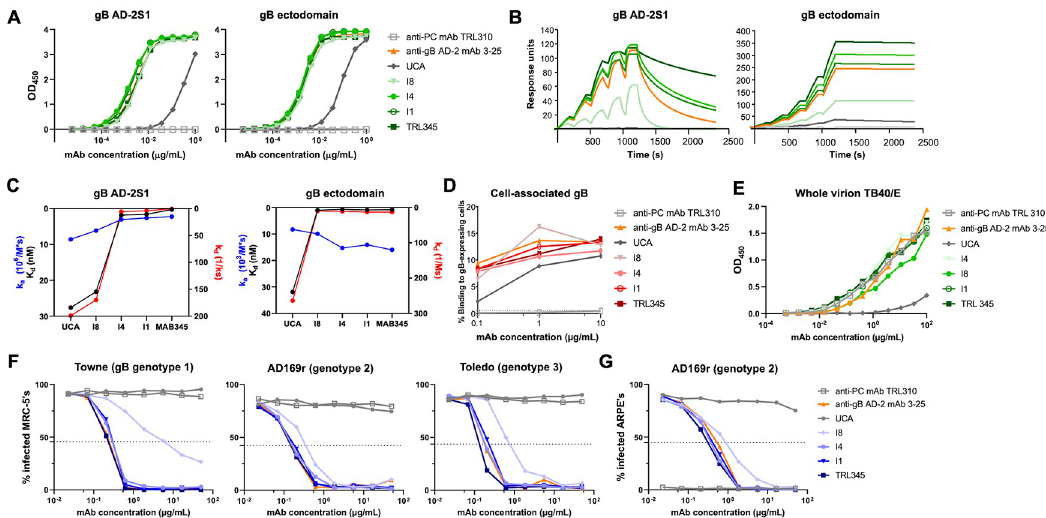
Fig 2. The TRL345 UCA acquired high binding to gB AD-2S1 and broad CMV neutralization function early in lineage development. We produced the 17 clonally related mAbs of the TRL345 lineage and quantified antigen binding and neutralization functions. Shown here are the responses of the lineage ancestors of TRL345: (A). Binding magnitude to gB AD-2S1 peptide and gB ectodomain by ELISA. (B). Binding to and avidity for gB AD-2S1 peptide and gB ectodomain by SPR. (C). Binding coefficients for gB AD-2S1 peptide and gB ectodomain by SPR. K d (nM) was calculated as k d /k a . (D). Binding to cell-associated gB. Binding of mAbs was determined by coincubating mAbs in a serial dilution with HEK293T epithelial cells-transfected with full-length gB and GFP. The % binding was calculated as the % of GFP-expressing cells bound by the anti-gB AD-2 mAb, detected by flow cytometry. (E). Binding to whole virion CMV strain TB40/E by ELISA. (F). Neutralization of CMV strains Towne, AD169rUL131-GFP (AD169r), and Toledo on MRC-5 fibroblasts. (G). Neutralization of AD169rUL131-GFP on ARPE epithelial cells. Each experiment was run with the negative control anti-CMV pentameric complex (PC) mAb TRL310 and positive control anti-CMV gB AD-2 mAb 3–25. For each figure, data are shown from one experiment, as the mean of two samples run in duplicate. Each figure is representative of results from two or more independent experiments.